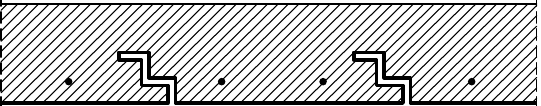
Fig. 4. Flat profiled sheet with